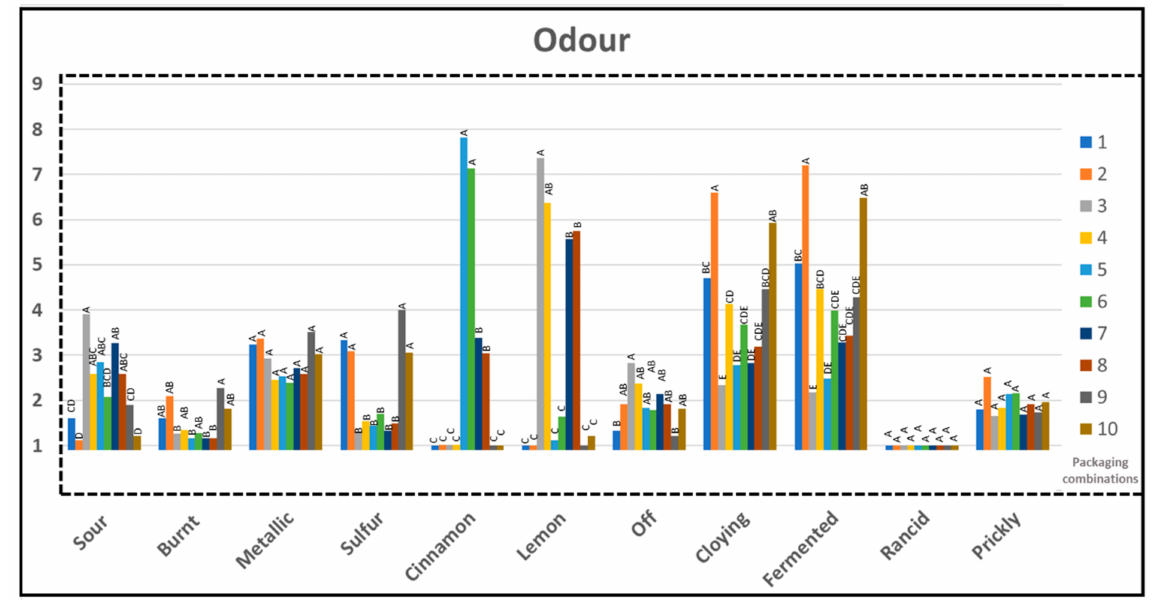
Figure 11. Mean intensities of the assessed odor attributes of all samples after 14 days of storage. Tukey group is represented by upper case letters, samples which do not share the same letter are significantly